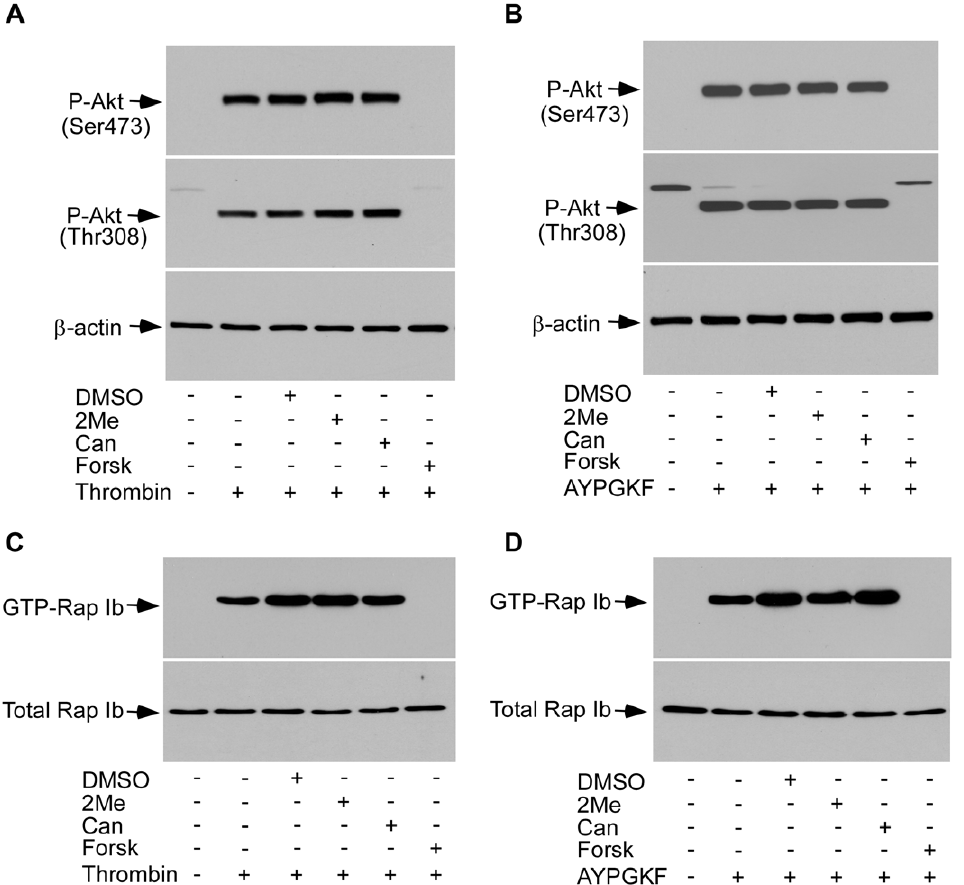
Figure 5. The PKA activators, but not 2MeSAMP and Cangrelor, inhibited Akt phosphorylation and Rap1b activation in P2Y 12 deficient platelets. (A-B) Washed platelets from P2Y 12 deficient mice were pre-incubated with 2MeSAMP (10 m M) (2Me), Cangrelor (1 m M) (Can), or forskolin (10 m M) (Forsk) at 37 u C for 5 min, and then stimulated with thrombin (0.25 U/ml) (A) or AYPGKF (500 m M) (B). Akt phosphorylation was detected by Western blotting with a rabbit monoclonal antibody specifically recognizing the phosphorylated Akt residue Ser 473 or Thr 308 . A mouse monoclonal antibody against b -actin (Sigma-Aldrich) was used to verify equal loading. (C–D) Washed platelets from P2Y 12 deficient mice were pre- incubated with 2MeSAMP (10 m M) (2Me), Cangrelor (1 m M) (Can), or forskolin (10 m M) (Forsk) at 37 u C for 5 min, and then stimulated with thrombin (0.25 U/ml) (C) or AYPGKF (500 m M) (D). GTP-bound Rap1 was precipitated with GST-RalGDS RBD bound to glutathione-agarose beads and detected by Western blot.